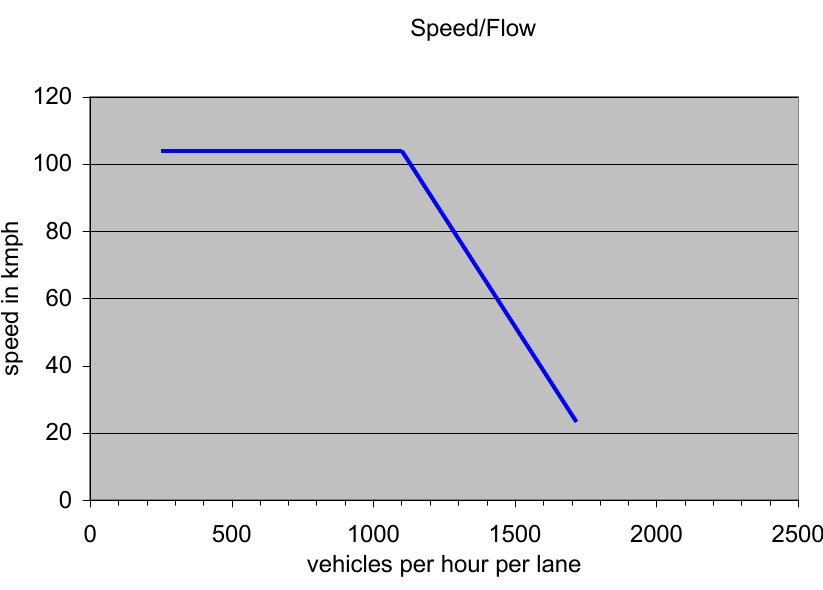
Figure 3. Simplified Model of Speed vs. Flow.